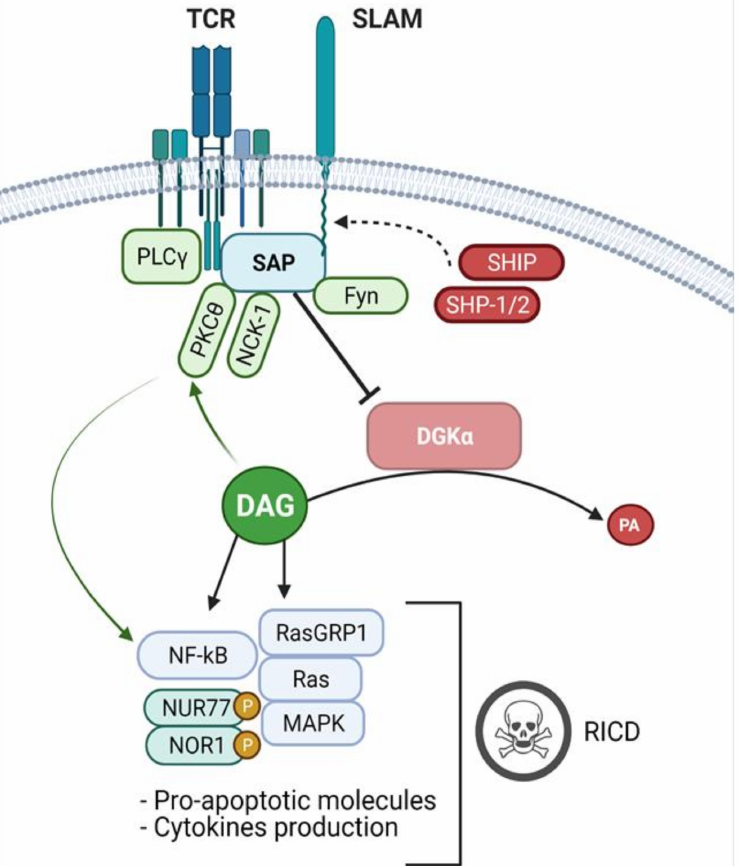
Figure 2. SAP signalling and DGK α inhibition. Upon TCR stimulation, the adaptor protein SAP binds to ITSMs sequences on the cytoplasmic tail of the SLAM-family and other receptors, competing with SHIP and SHP-1/2 phosphatases and promoting activator signals. At the membrane, SAP interacts with different binding partners, such as the FYN Kinase, PKC θ and NCK1, involved in T-cell activation. Moreover, SAP mediates the inhibition of DGK α , resulting in an accumulation of PLC γ -derived DAG, leading to MAPK pathway activation, pro-apoptotic molecules expression and cytokines production. Furthermore, the increased levels of DAG enhance PKC θ activity re- sulting in signalling which potentiates NF κ B activation. In antigen-experienced CD8 + cells, these events trigger the RICD program, which promotes effector T-cells clearance and prevents excessive